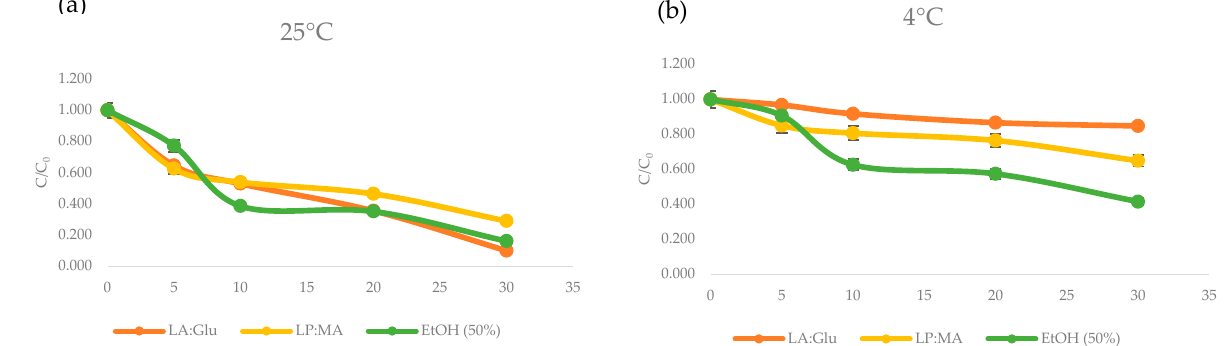
Figure 6. Stability of phenols in NADES (La:Glu, LP:MA) and ethanol (50% v / v ) extracts at 25 °C ( a ) and 4 °C ( b ) during storage for 30 days. Results were expressed as the means (n = 3) ± SD.